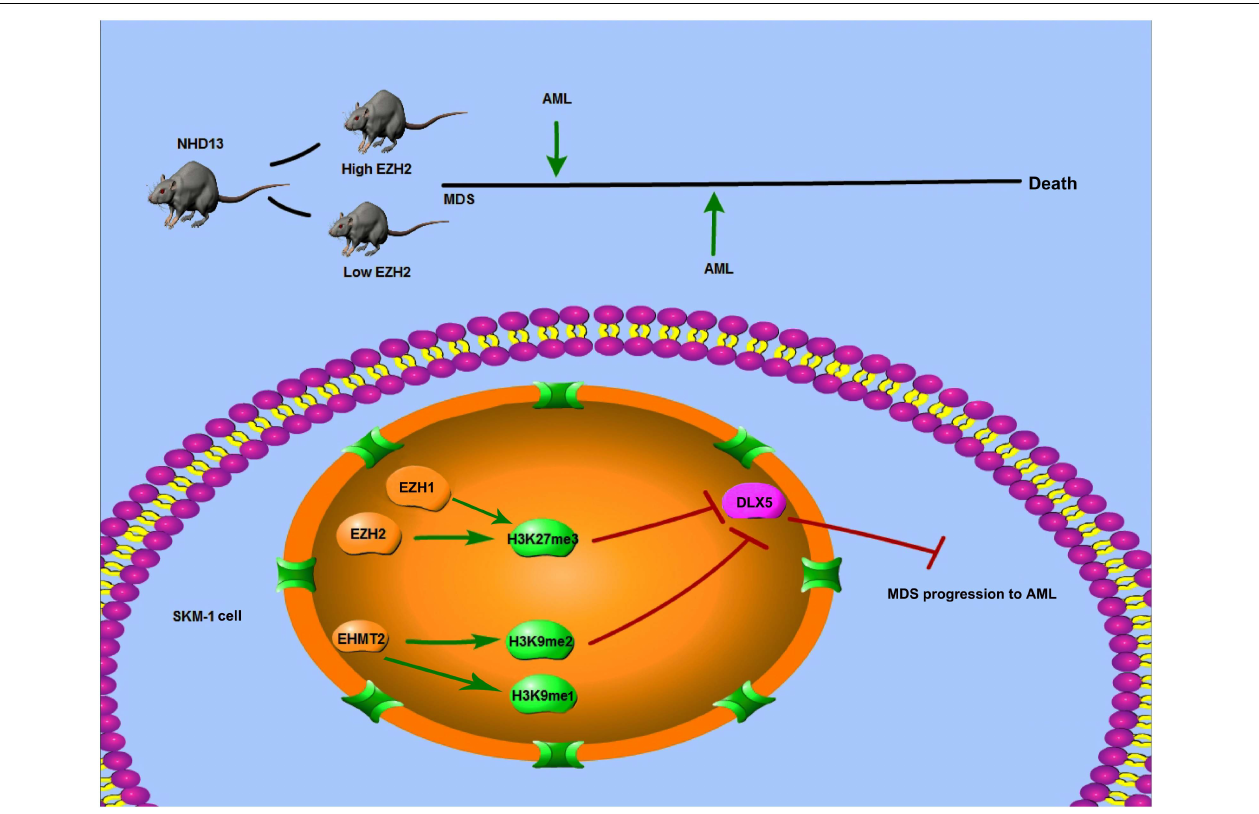
FIGURE 9 | Mechanism diagram. EZH2 and EHMT2 synergistically regulated DLX5 transcription and promoted the transformation from MDS to AML. NHD13 mice with high EZH2 expression in peripheral blood had earlier AML transformation. EZH1 and EZH2 regulated the level of histone H3K27me3, and EHMT2 catalyzed H3K9me1 and H3K9me2. EZH2 and EHMT2 regulated the histone methylation level of DLX5 promoter region, synergistically inhibited the transcription of DLX5, and then promote the transformation of MDS into